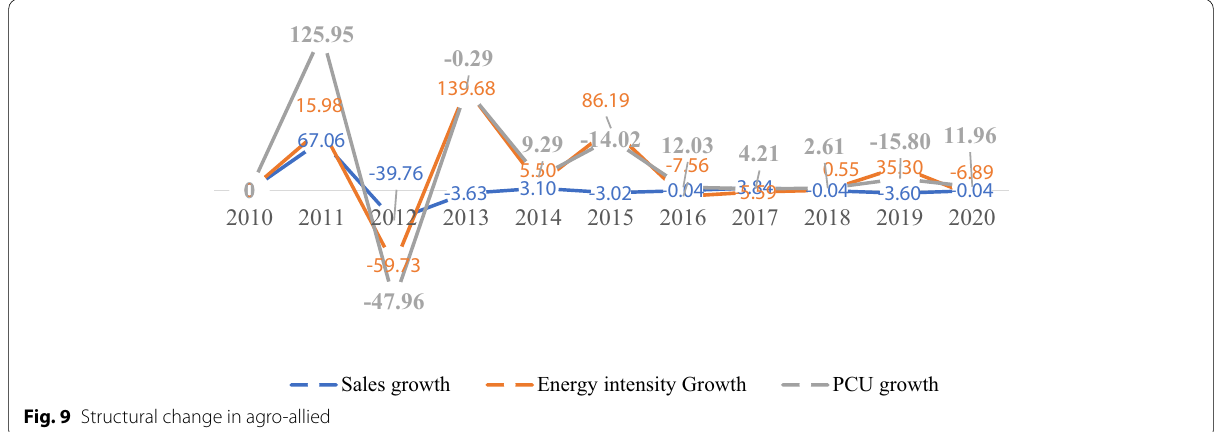
Fig. 9 Structural change in